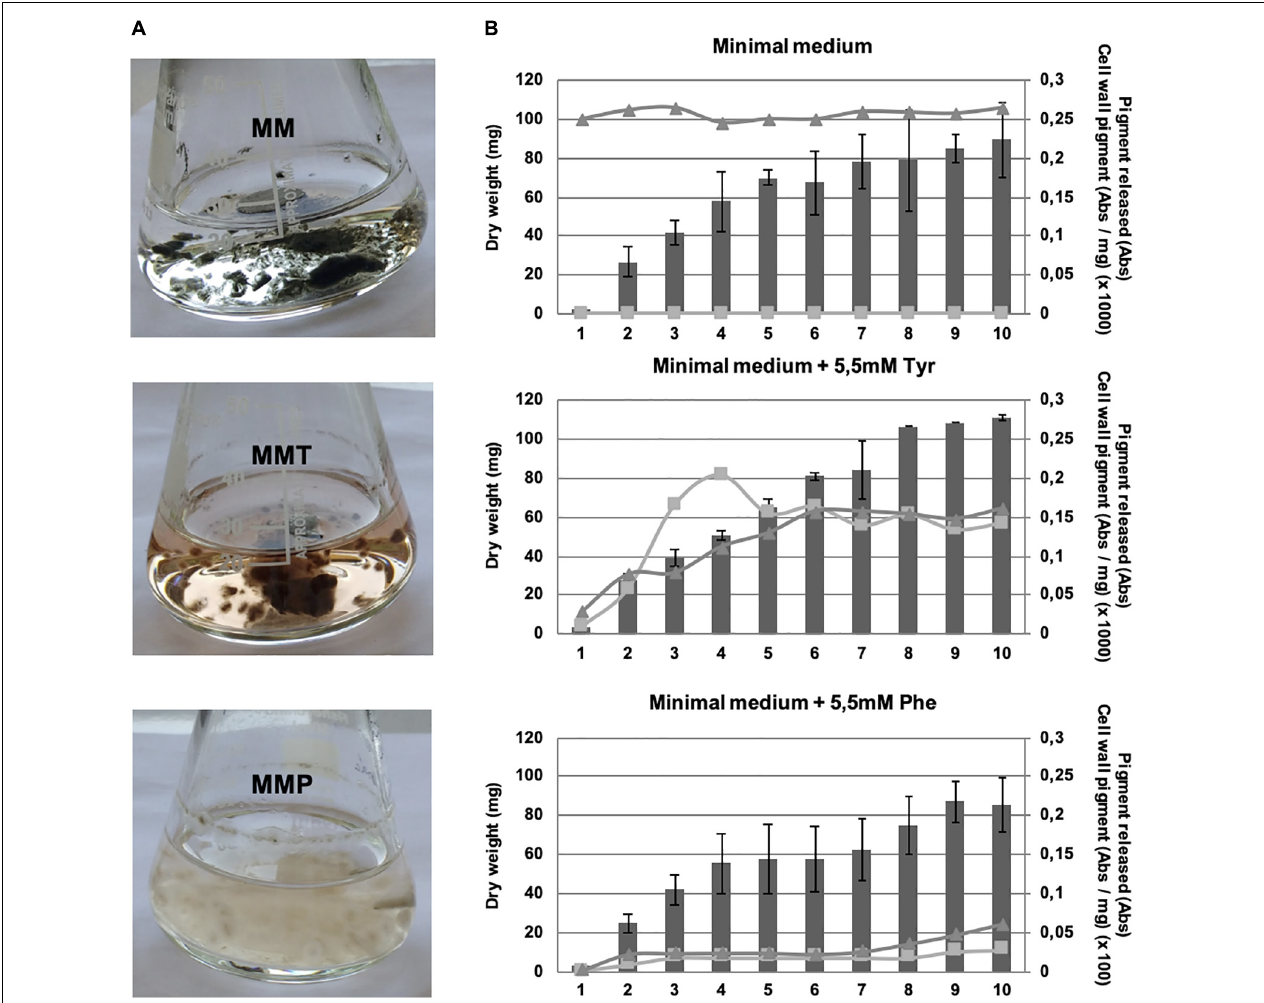
FIGURE 2 | A. alternata melanin synthesis during mycelial growth. (A) Pigment formation of A. alternata grown in MM, in MM supplemented with 5.5 mM of L-tyrosine (MMT) and in MM supplemented with 5.5 mM of L-phenylalanine (MMP) after 3 days of growth. (B) Mycelial growth and quantification of the melanin content in A. alternata cells and released in liquid cultures over 10 days. Bars, mycelium dry weight; squares, pigment released into the medium, given as the absorbance at 405 nm (Abs); triangles, cell wall pigment content, measured by determination of the absorbance at 405 nm, as described in section “Materials and Methods”, and given as the absorbance (Abs) per milligram (dry weight) of mycelia ( × 1,000 for the scale of MM and MMT growth and × 100 for the MMP growth